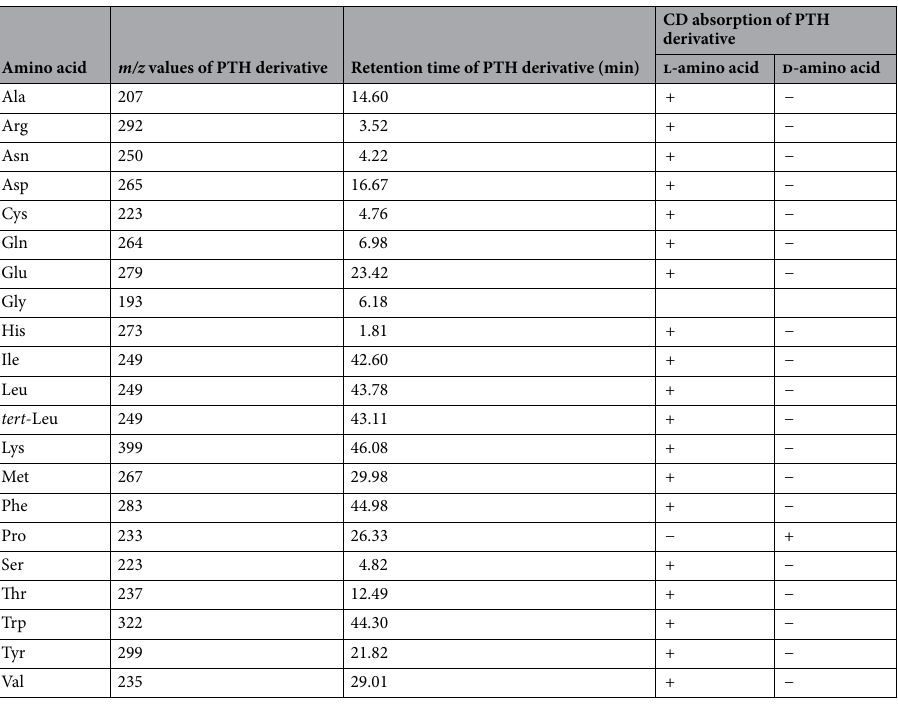
Table 1. Identification of PTH derivatives based on their retention times, m/z values, and CD absorption at 270 nm.